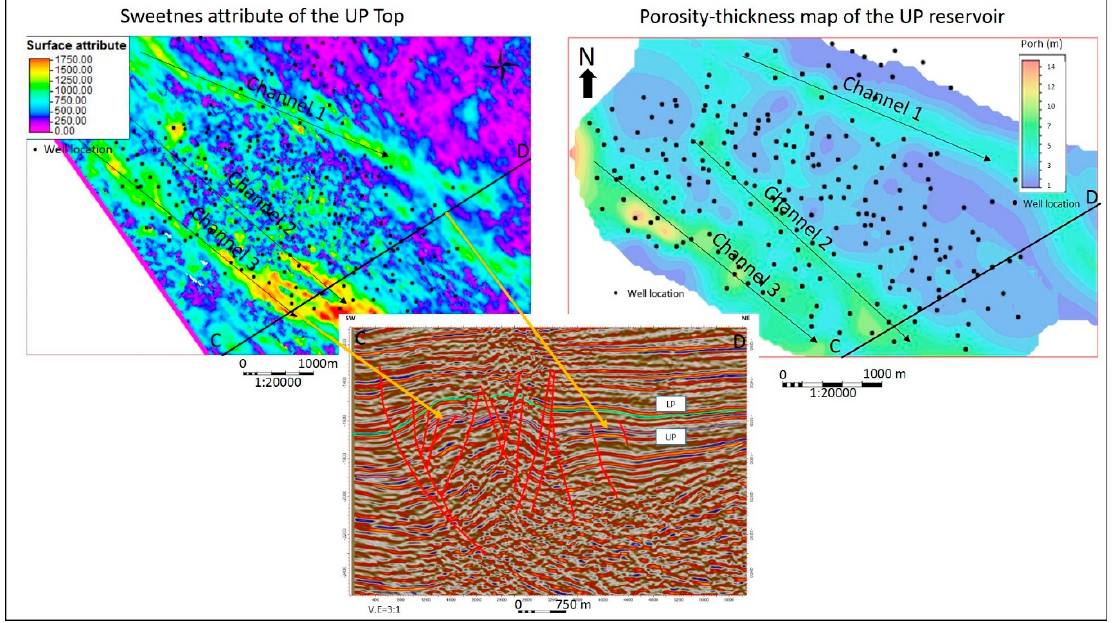
Figure 11. Comparison of the sweetness attribute and porosity–thickness map of the “UP” reservoir.